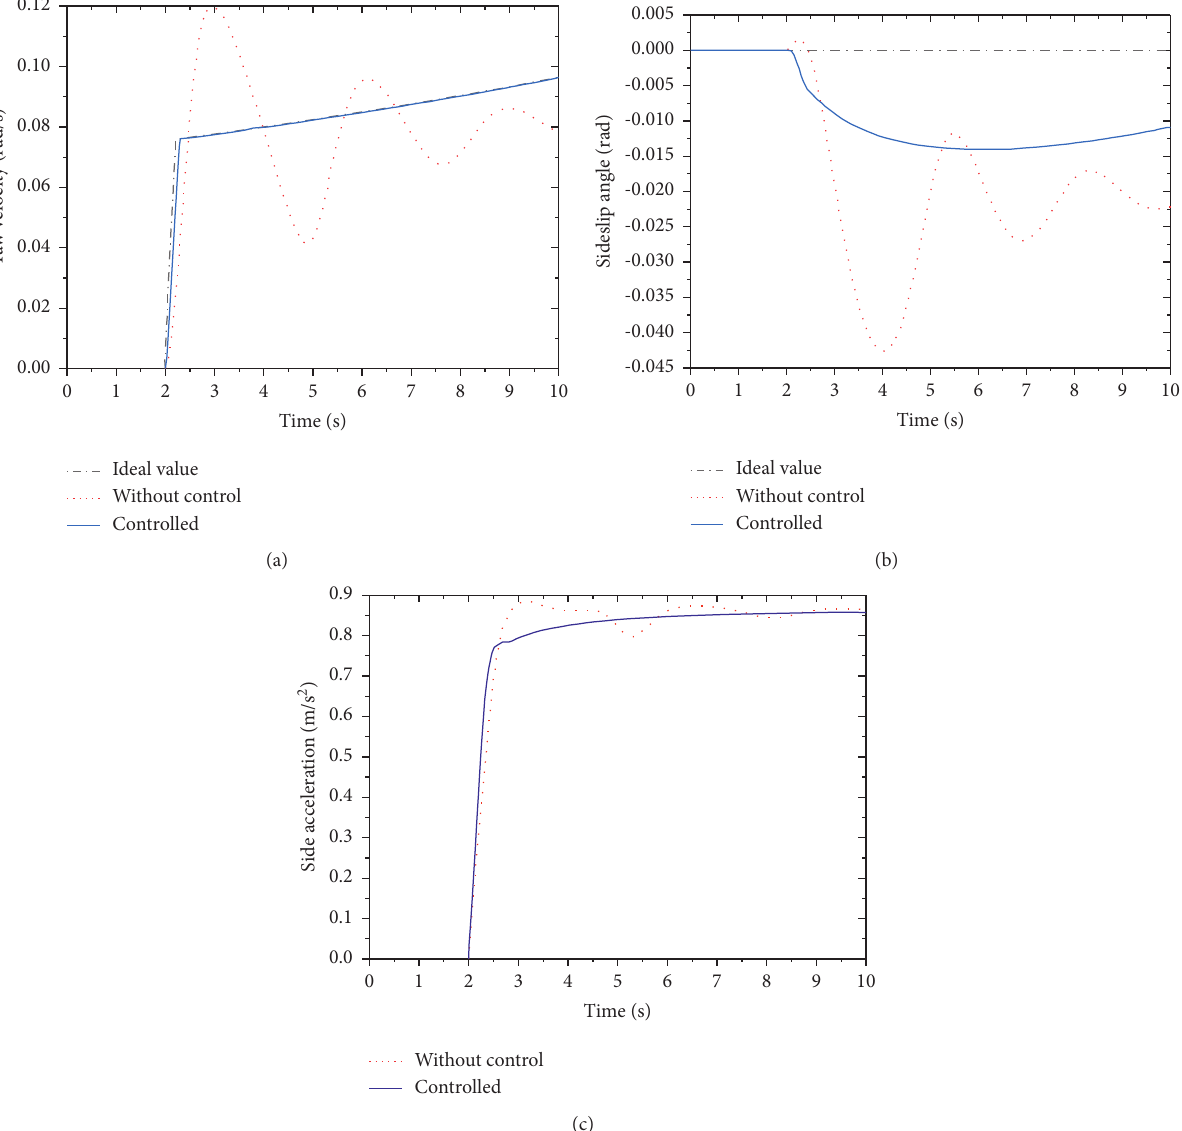
Figure 12: Simulation results of front-wheel angle overstep at an initial speed of 40km/h. (a) Change of yaw rate. (b) Change of sideslip angle of centroid. (c) Change of lateral